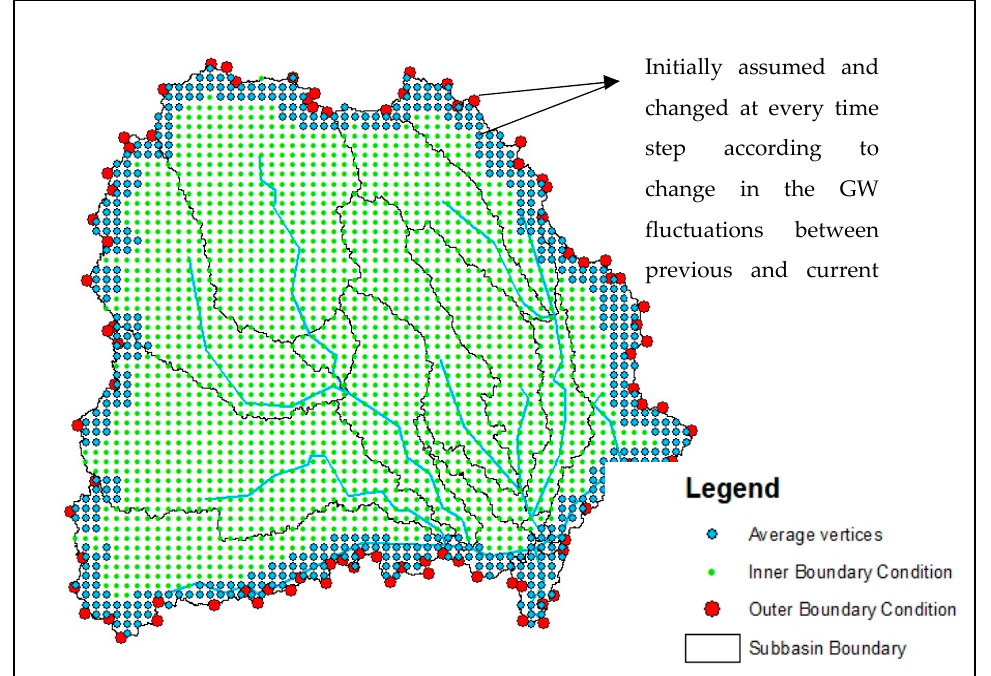
Figure 5. Boundary Condition in SWAT-AEM model.